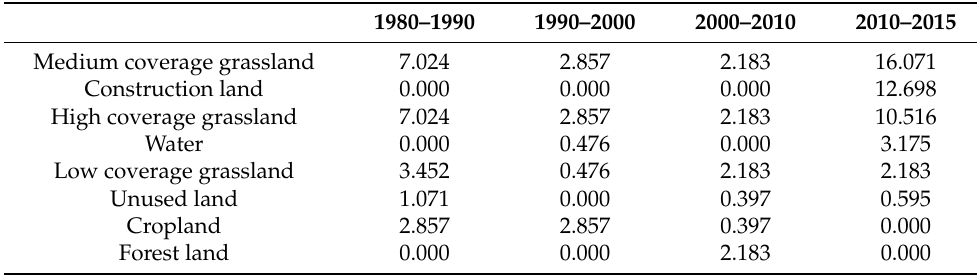
Table 4. Betweenness of nodes in transfer matrix networks between